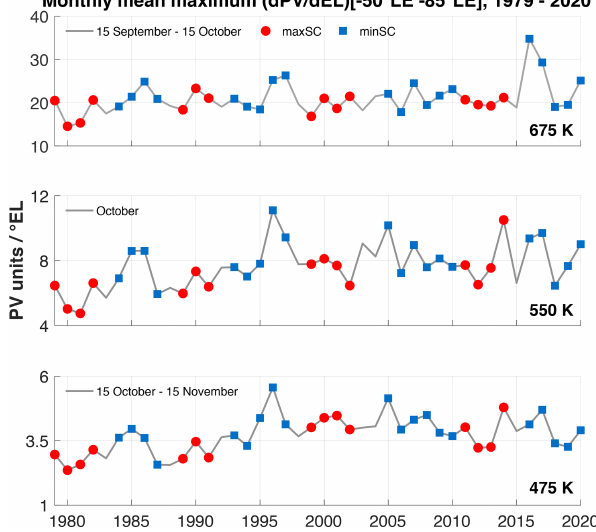
Figure 8. Interannual evolution of the vortex edge position for the period 1979–2020, averaged over 15 September–15 October for 675K, 1–31 October for 550K, and 15 October–15 November for 475K. The maxSC years are represented by red circles and the minSC years by blue